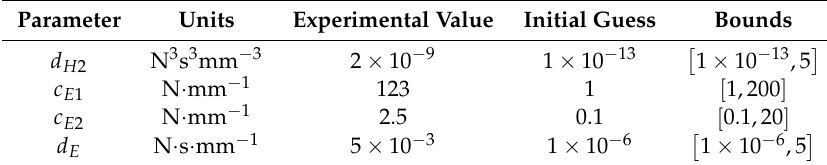
Table 5. Parameters to be identified in the hydraulic engine mount system model